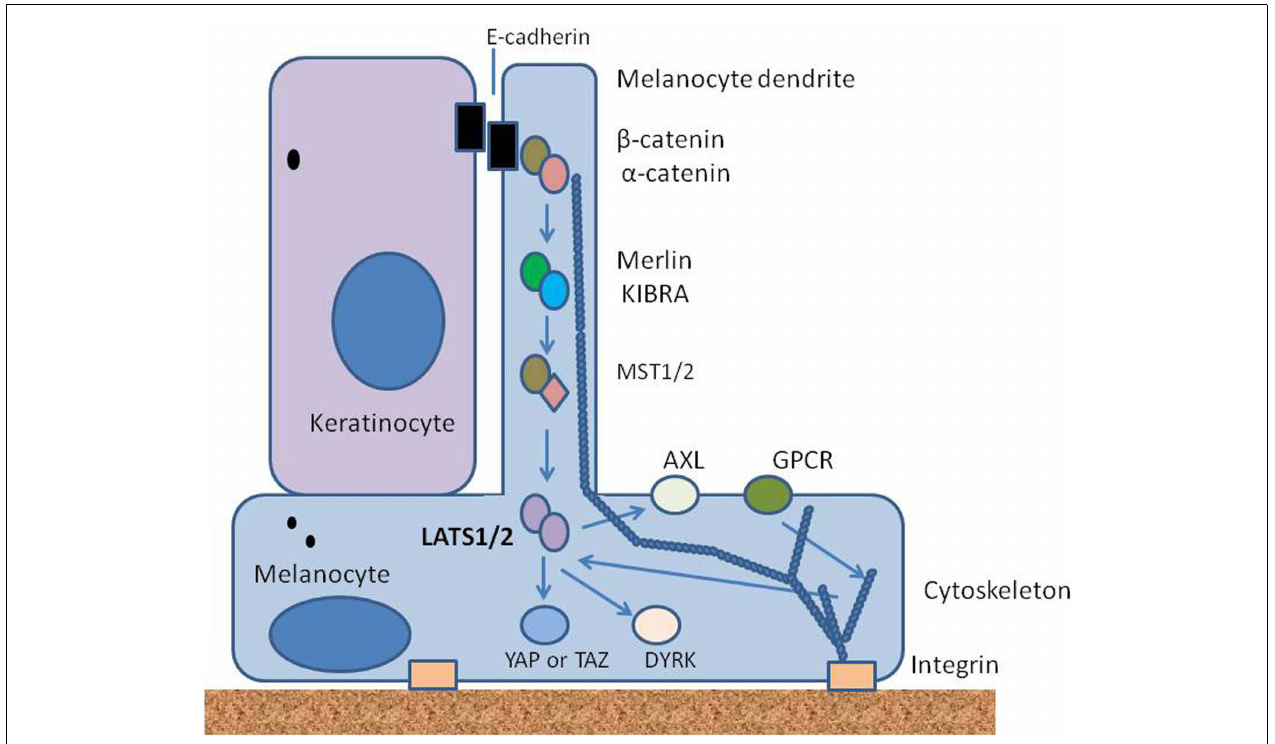
membrane through integrins.They also receive signals through receptor tyrosine kinases such as Axl and through G-protein coupled receptors (GPCRs). All are likely to signal through kinases to Lats1/2; arrows indicate signaling